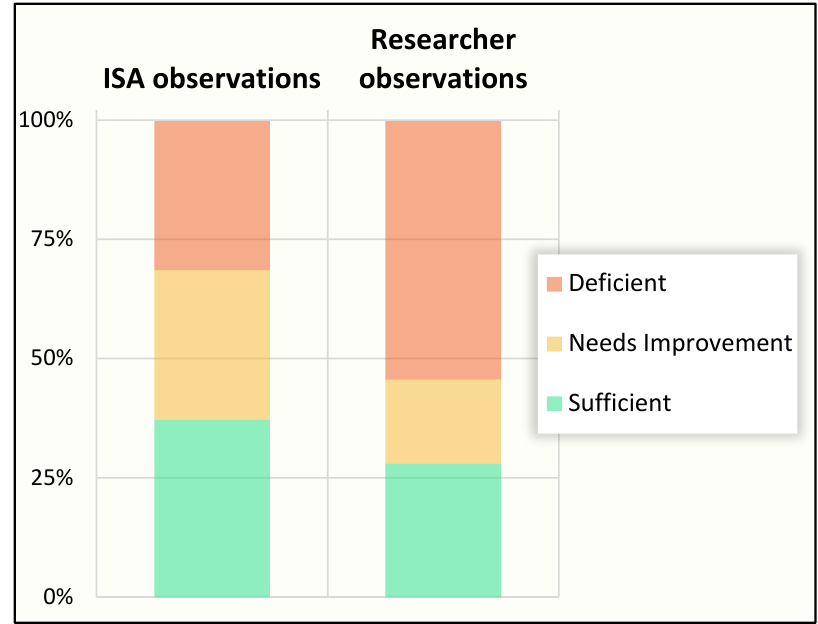
Figure 6. Summary of independent assessments of H3 intervention